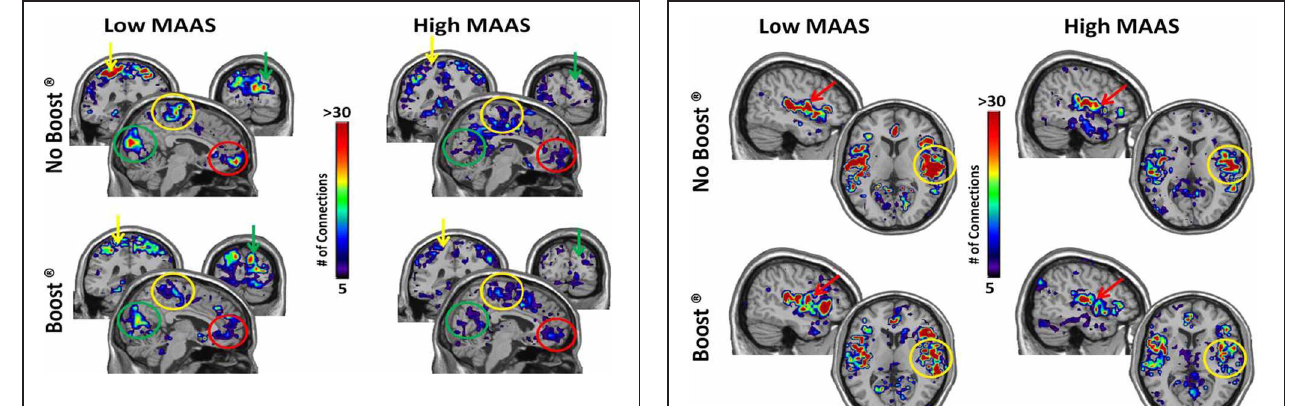
FIGURE 5 | Connectivity Maps from Insula/Auditory Cortex by MAAS Category. This figure shows brain regions that are two steps removed from the auditory cortex. Thus, when tracking connections from the auditory cortex, the colored areas were reached after making two steps. Color bar represents the average number of connections across subjects for each voxel: sensorimotor cortex (yellow arrow), visual cortex (green arrow), orbital frontal cortex (red arrow).